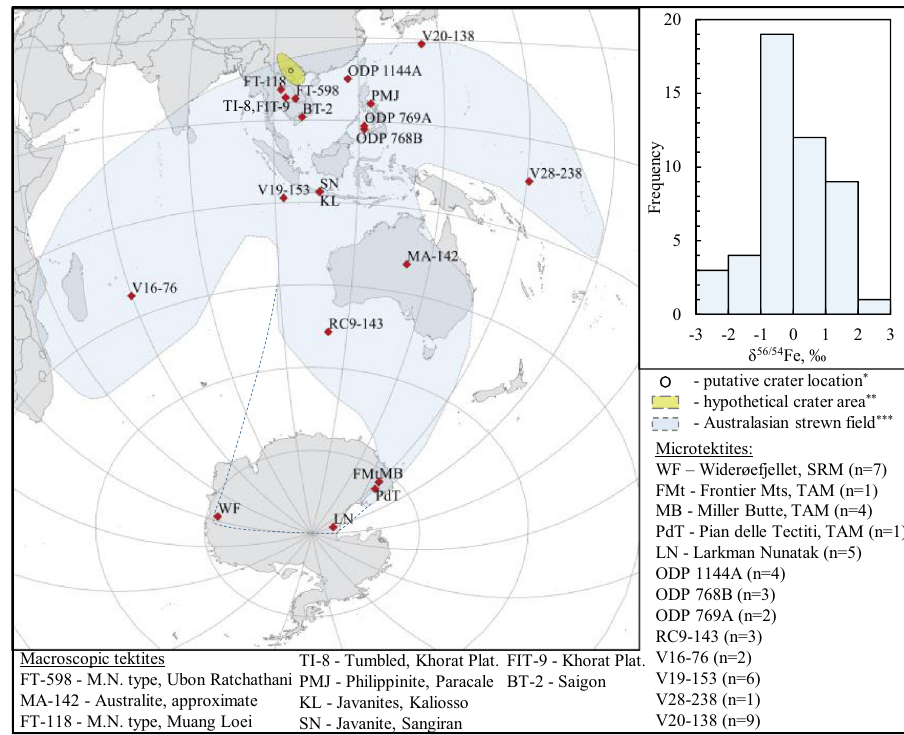
Fig. 1 Collection sites of the tektites and microtektites studied. The microtektites are collected from the sea sediments and sedimentary traps in Antarctica. n corresponds to the number of microtektites studied from each location. Top right – frequency distribution plot for δ 56/54 Fe values of the microtektites. * 22° N and 104° E is one of the proposed crater locations based on the abundance of unmelted ejecta and microtektites 12 . ** A location of the impact crater anywhere within the yellow oval explains the distribution of the microtektites and impact ejecta equally well 12 . ***Australasian strewn fi eld after Folco et al 80 . extended to the Transantarctic Mountains 12 . The blue dashed line suggests an extension of the central lobe to the Widerøefjellet, SRM 16 . M.N. Muong Nong tektite shape type, WF Widerøefjellet, SRM Sør Rondane Mountains, Antarctica, FMt Frontier Mountains, Antarctica, TAM Transantarctic Mountains, Antarctica, MB Miller Butte, Antarctica, PdT Pian delle Tectiti, Antarctica, LN Larkman Nunatak, Antarctica, ODP microtektites from ocean sediments collected during Ocean Drilling